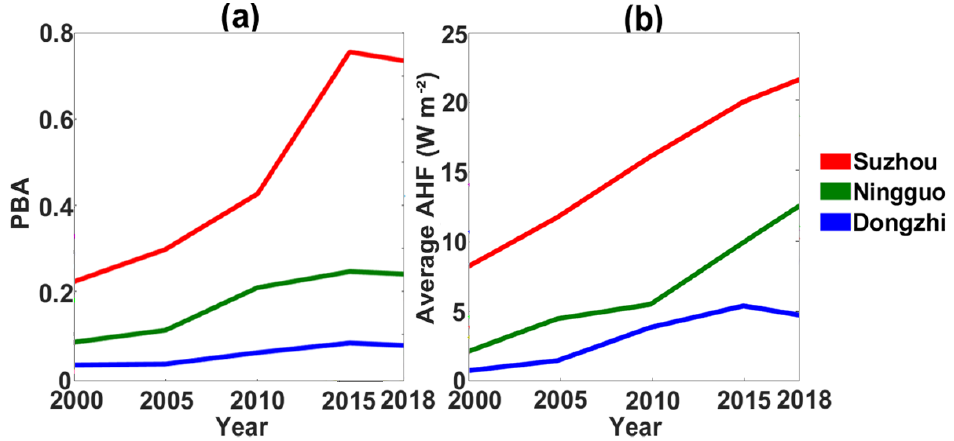
Figure 10. Linear graph of the changes in ( a ) the PBA and ( b ) the average AHF in the 5 km radius buffer zone around the reference stations: Suzhou (SZ), Ningguo (NG) and Dongzhi (DZ) in Figure